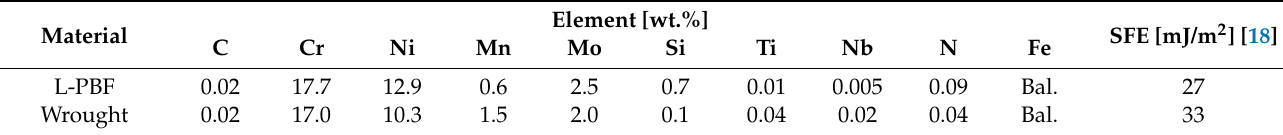
Table 1. Chemical composition and stacking fault energy of additively manufactured and commercial wrought AISI 316L. Material